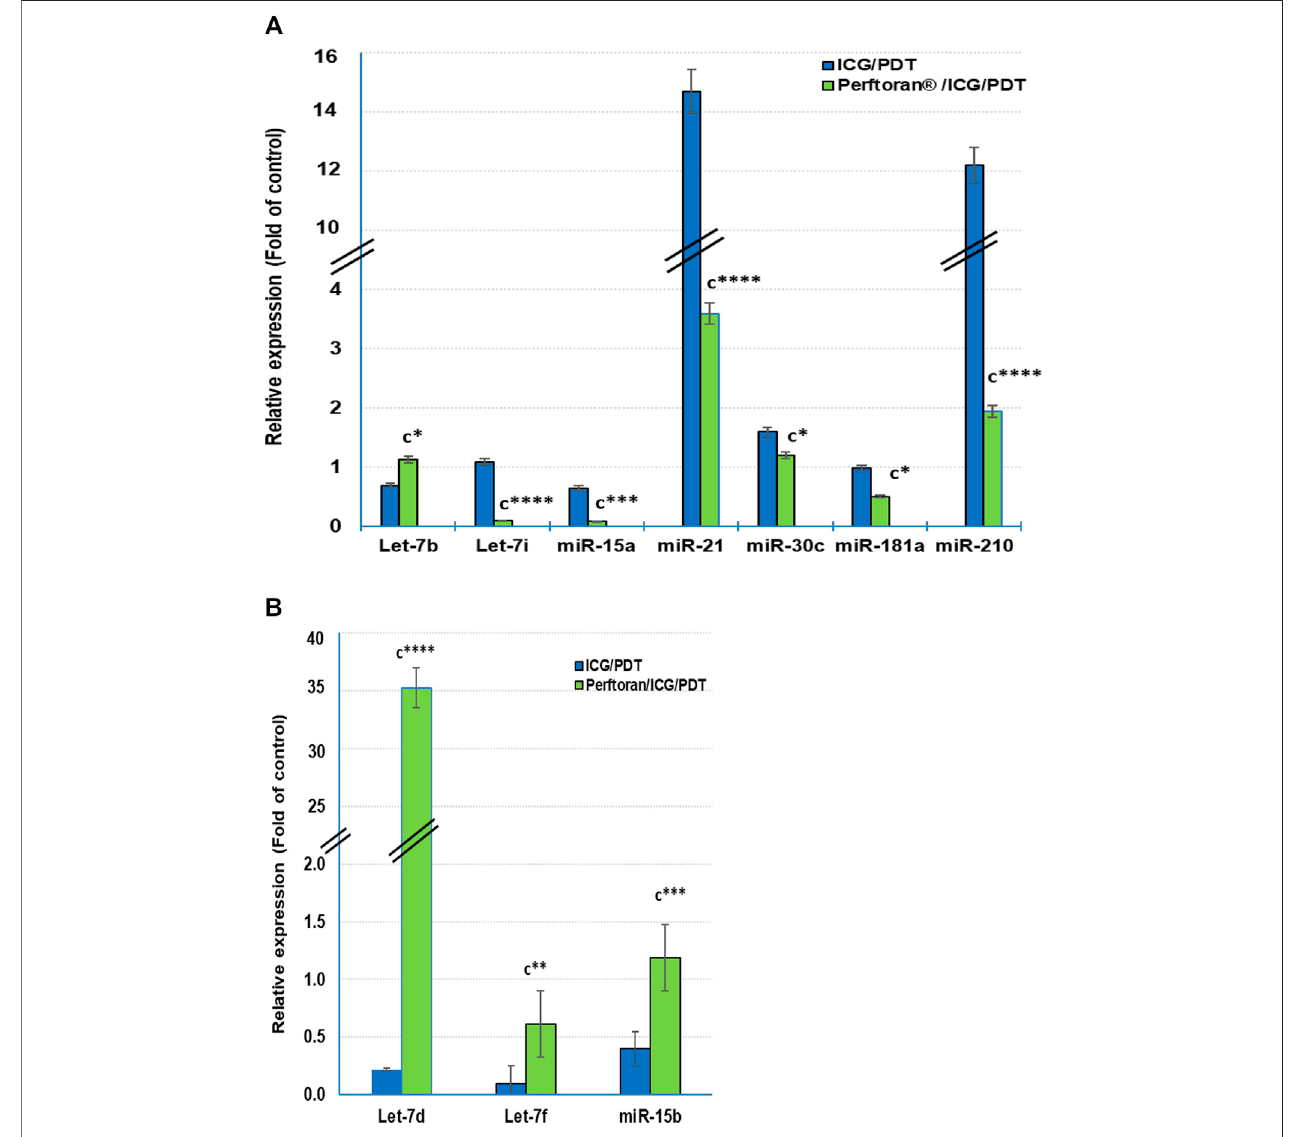
FIGURE 4 | Expression of the known hypoxia-upregulated miRNAs (A) and the known hypoxia-downregulated miRNAs (B) : Relative expression of miRNAs was estimated byqRT-PCR. Theresults are expressed as foldofcontrol. The results werecomparedto thoseof c ICG/PDT-treated cells; * p < 0.05, ** p < 0.01, *** p < 0.001, and **** p <